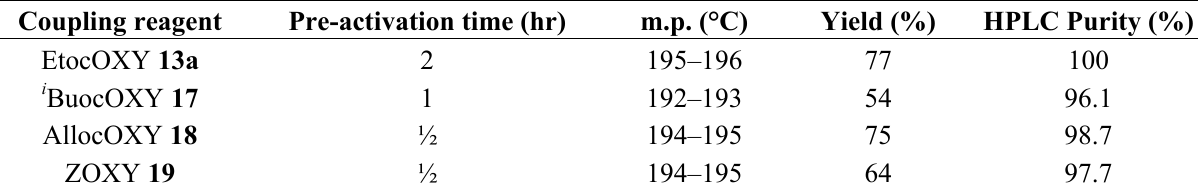
Table 12. Coupling of Fmoc-Val-OH with H-Ala-OMe 28 using different oxime carbonate derivatives. Coupling